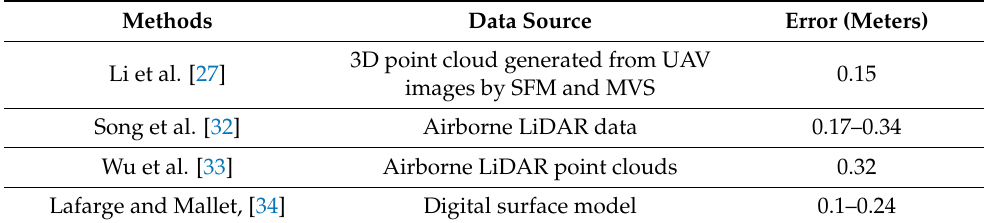
Table 2. A comparison study on previously obtained results by relevant